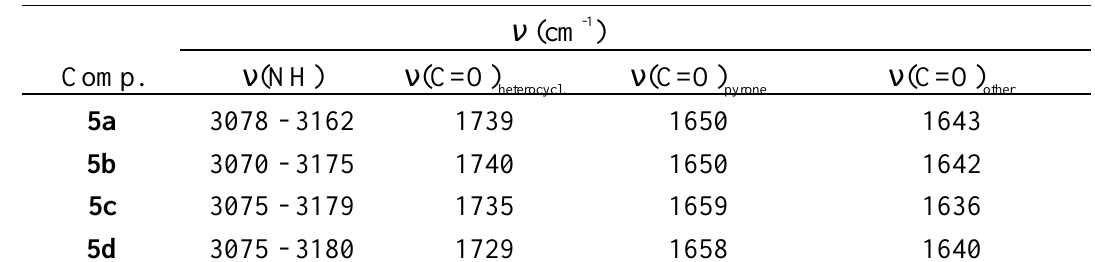
Table 3. IR spectral data of synthesized compounds 5 - 9